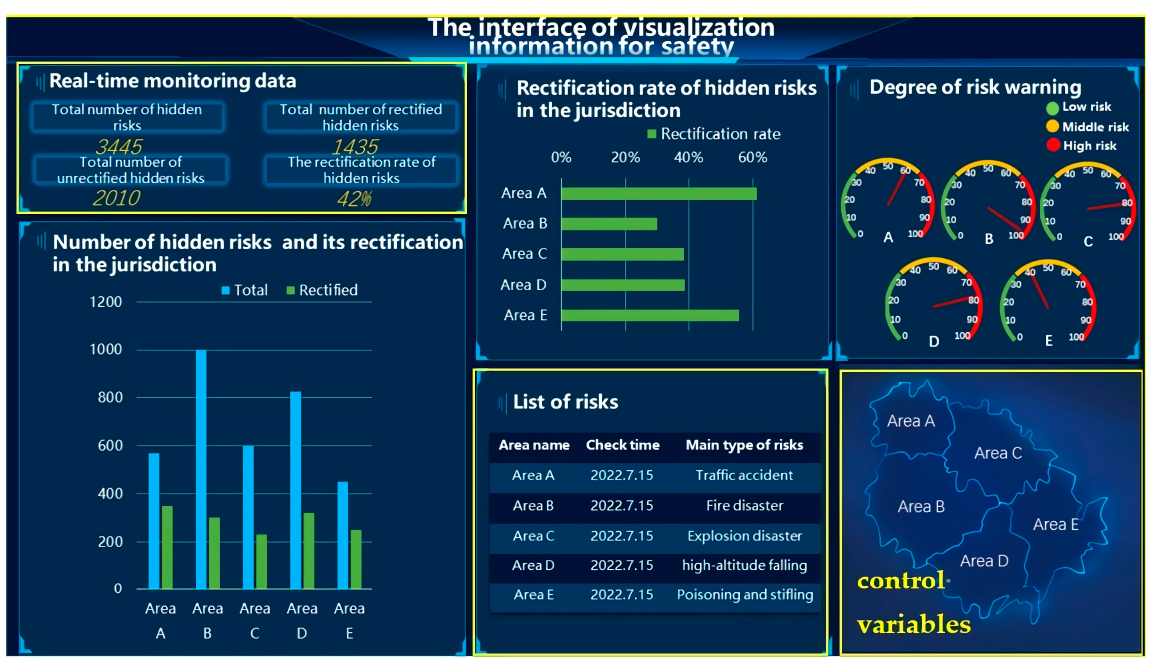
Figure 3. Control-variable modules in the UI design. Note. The yellow-line box shows the corre- sponding control modules. sponding control